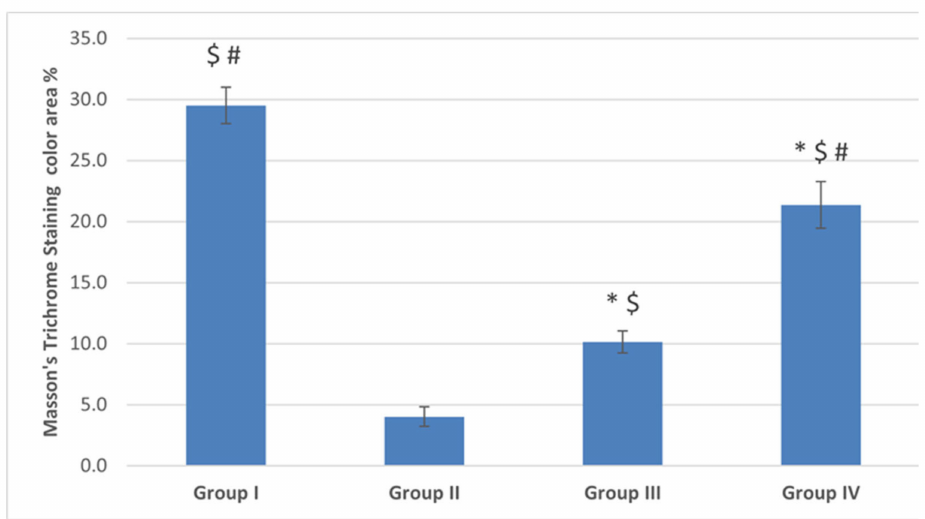
Figure 9. The mean color area percentage of the green stained collagen. Data are expressed as means ± SEM ( n = 6) and analyzed using one-way ANOVA followed by post-hoc Bonferroni multiple comparison test. (Symbols: *: p ≤ 0.05 compared to the control group (Group I); $: p ≤ 0.05 compared to the POI group (Group II); #: p ≤ 0.05 compared to diosmin 50 group (Group